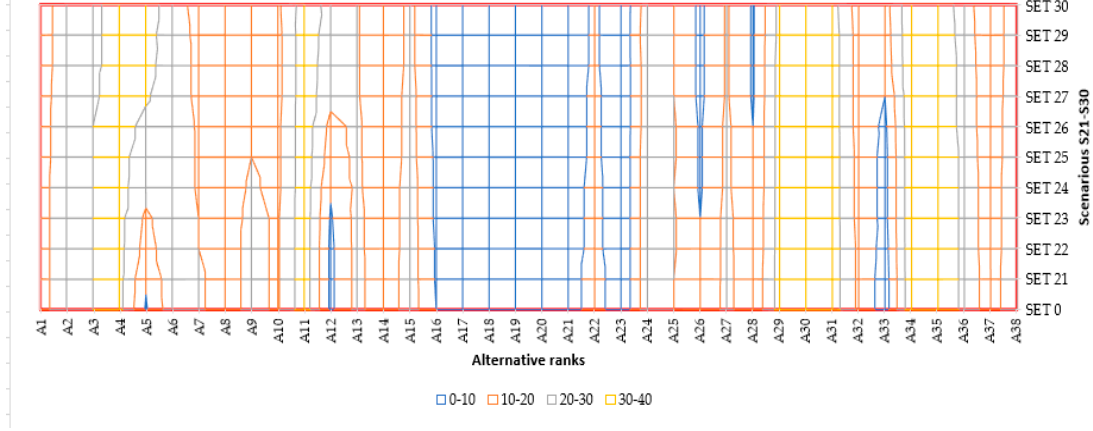
Figure 4. Comparison of initial results with third group of scenarios i.e., S21–S30.